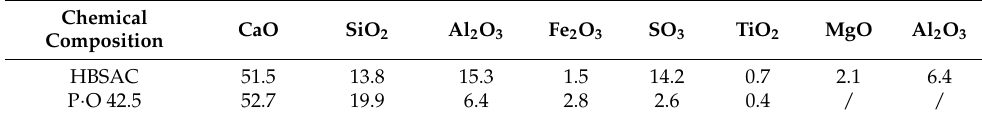
Table 1. Chemical composition of the raw materials by XRF (wt.%).